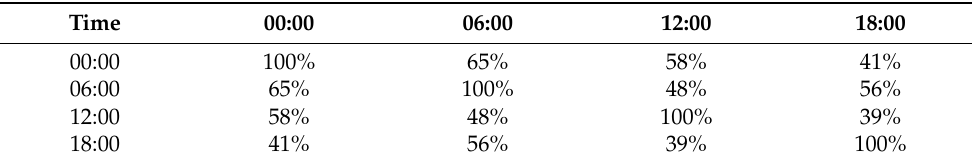
Table 4. Similarity * table among different diurnal times with respect to fungal species encountered from 72 exposure samplings in the atmosphere of Doha, Qatar, during the period 1 February to 31 March 2016. Time 00:00 06:00